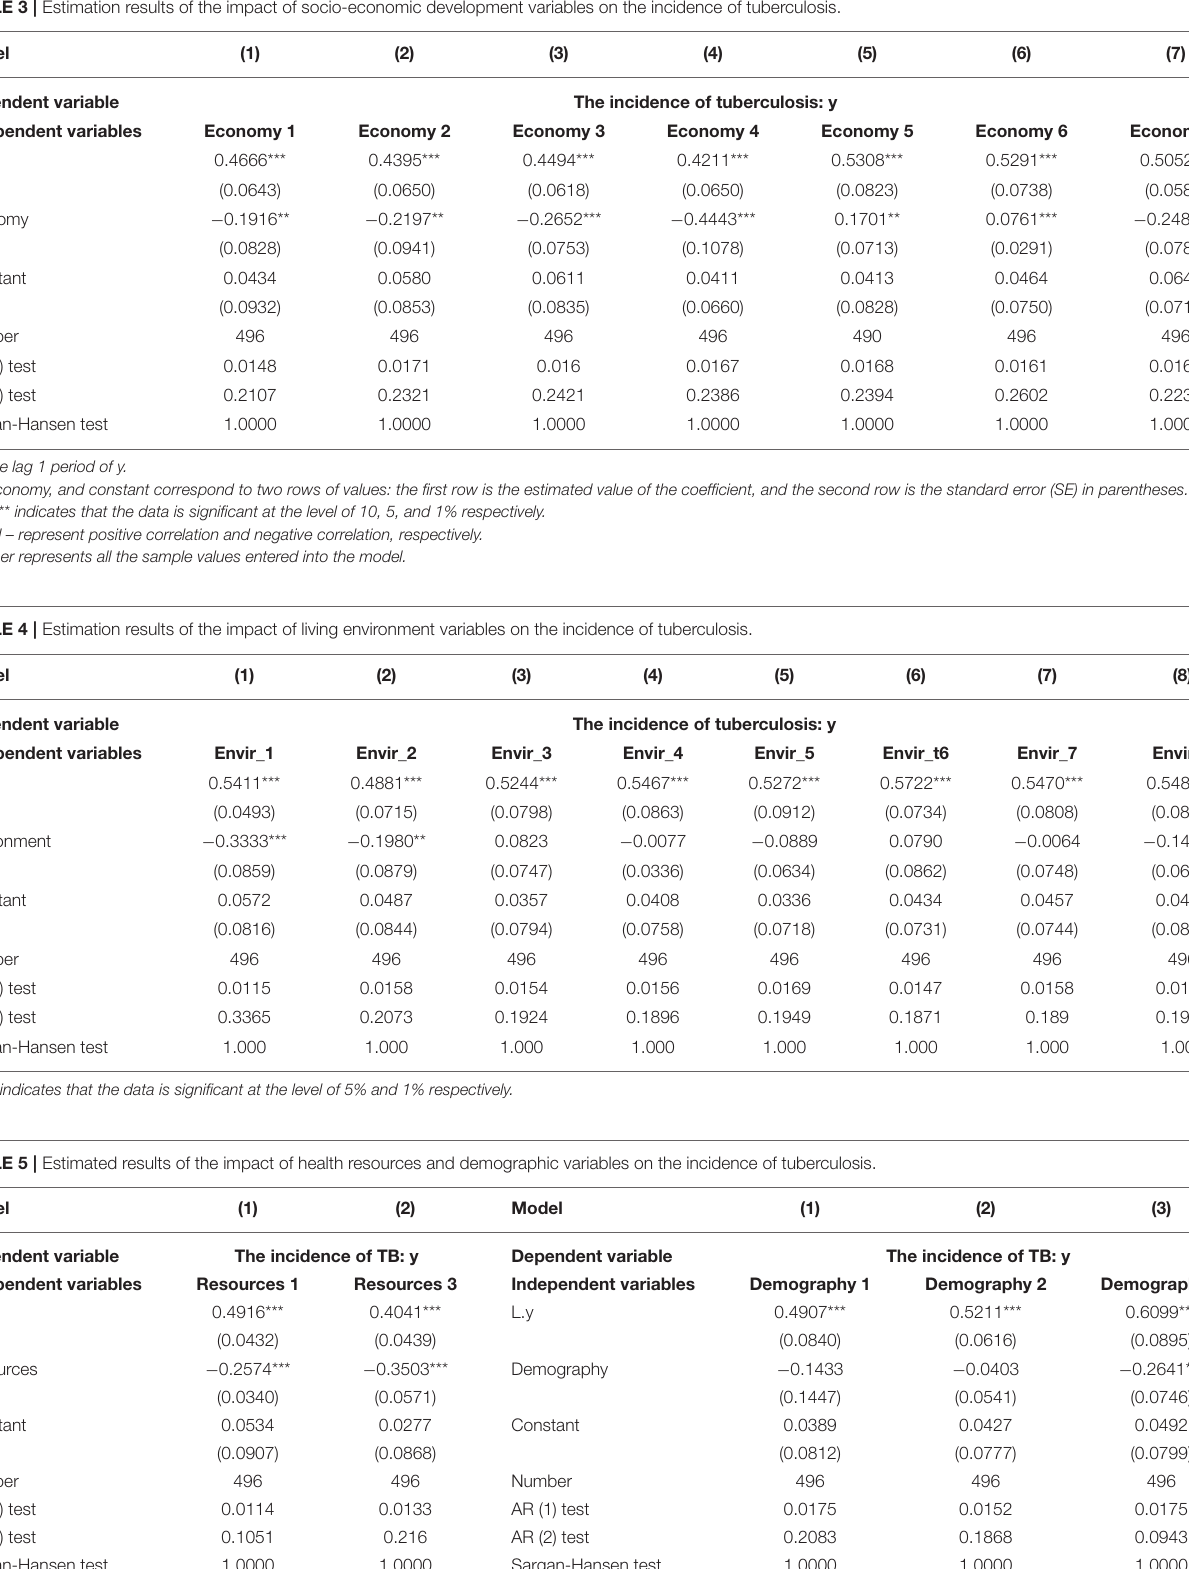
TABLE 3 | Estimation results of the impact of socio-economic development variables on the incidence of tuberculosis.